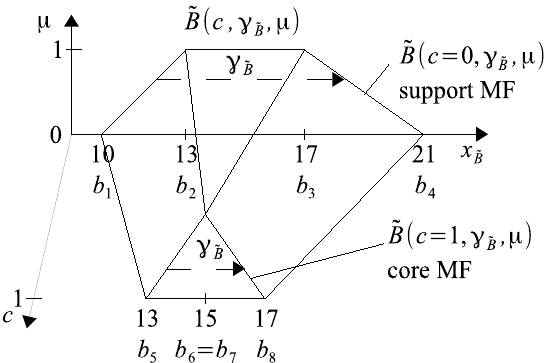
Figure 16. Type-2 fuzzy number ˜ B in 3D-space.